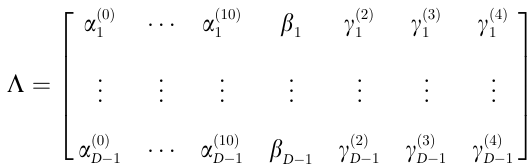
S1 Fig. Calibration curve for mock community data. The marginal regression line for the relation between PCR cycle number and microbial composition (mean and 95% credible set).